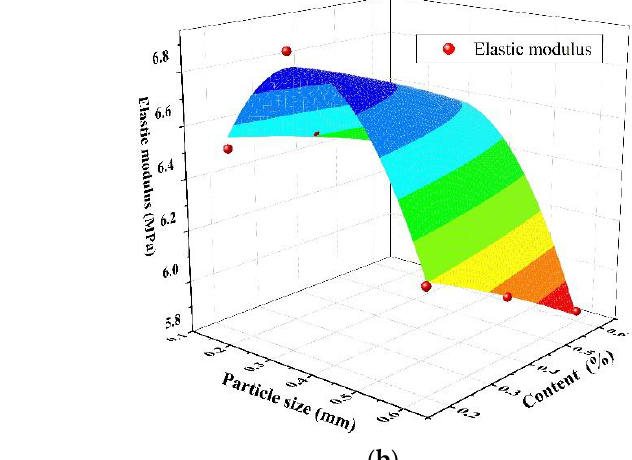
cement ratio of 0.37.